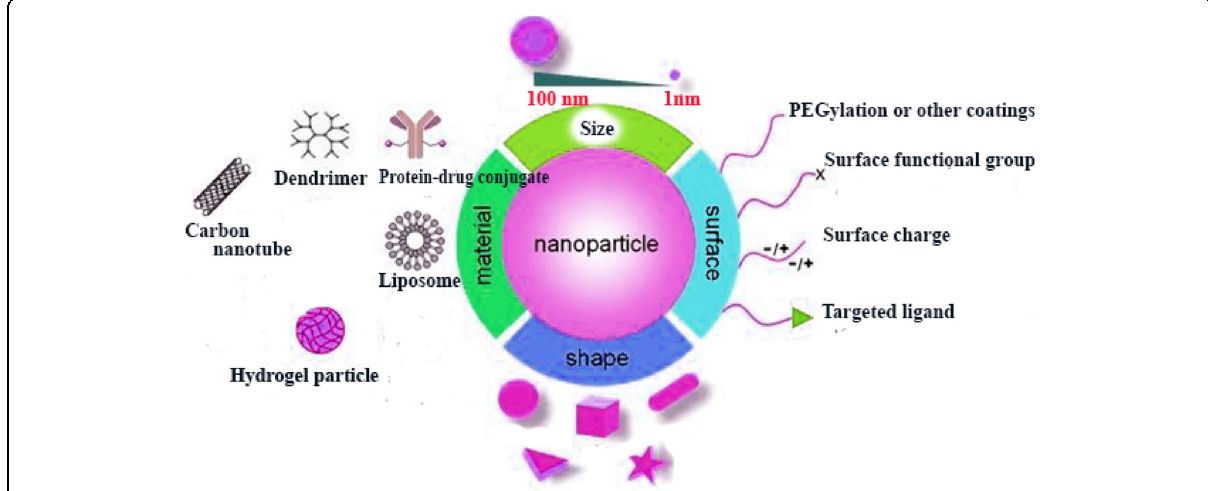
Fig. 1 Schematic representation of